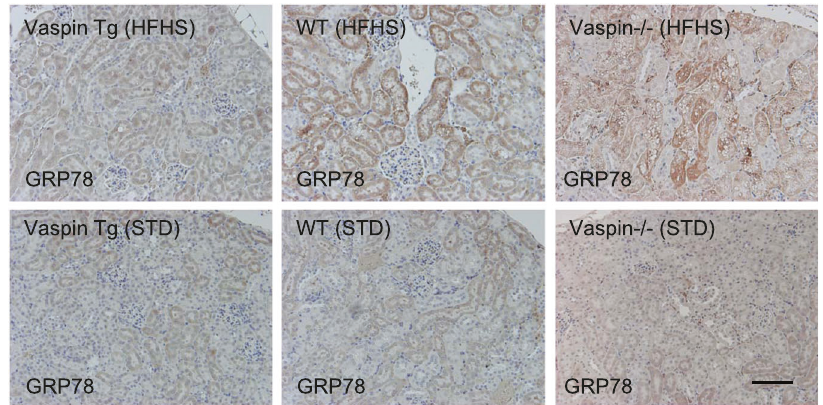
Fig. 10 Immunohistochemical staining using kidney tissues of Vaspin Tg, WT and Vaspin − / − mice under high-fat high-sucrose (HFHS) or standard (STD) diet. Bar = 100 μ m. Immunoperoxidase staining studies were repeated